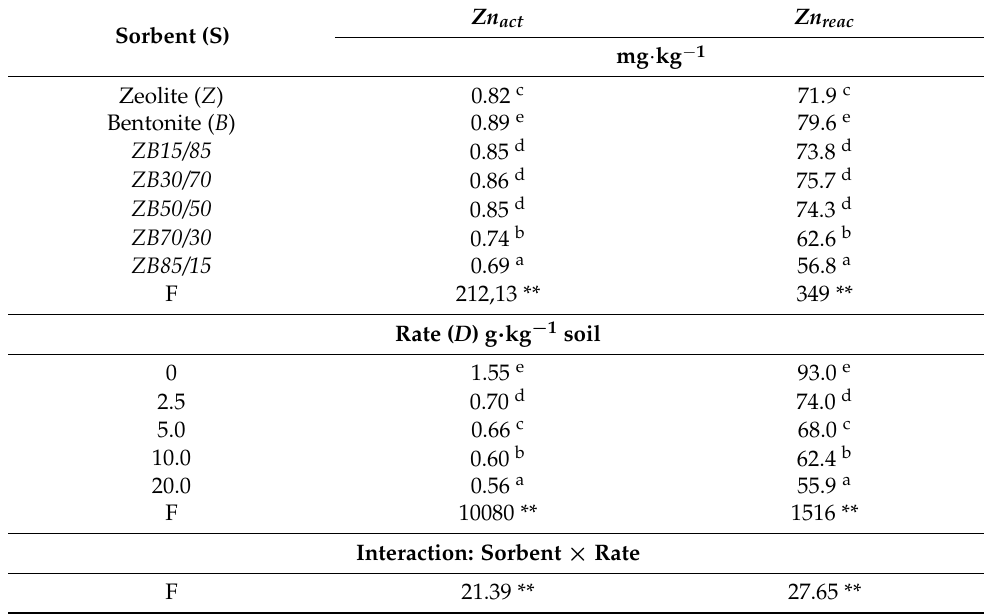
Table 4. Content of the active and reactive Zn fractions as affected by sorbents application.